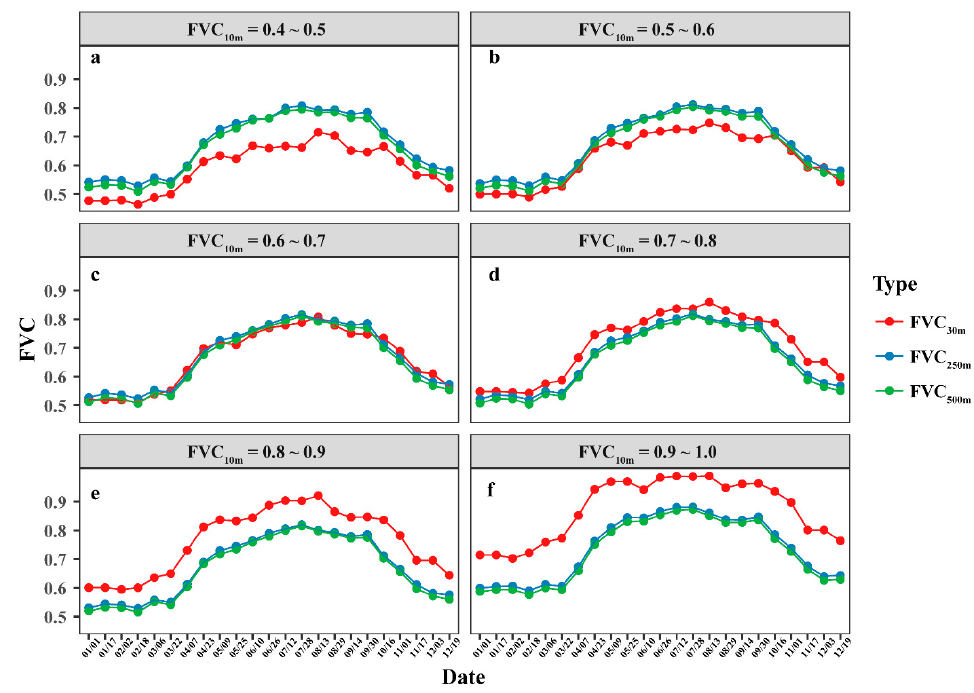
Figure 7. Annual temporal profile of the mean value of each FVC level from three spatial resolution images. ( a ) FVC 10m is 0.4~0.5. ( b ) FVC 10m is 0.5~0.6. ( c ) FVC 10m is 0.6~0.7. ( d ) FVC 10m is 0.7~0.8. ( e ) FVC 10m is 0.8~0.9. ( f ) FVC 10m is 0.9~1.0. Finally, the difference rate between FVC 30m and FVC 250m /FVC 500m was analyzed, as shown in Figure 8. The FVC 30m and FVC 250m /FVC 500m difference rates are almost the same at each FVC level, as the temporal profiles of FVC 250m and FVC 500m are very similar. When FVC 10m is less than 0.6, the difference between FVC 30m and FVC 250m /FVC 500m is less in spring and autumn and greater in summer and winter. However, when FVC 10m is higher than 0.7, the difference between FVC 30m and FVC 250m /FVC 500m is greater in spring and autumn and lower in summer and winter.